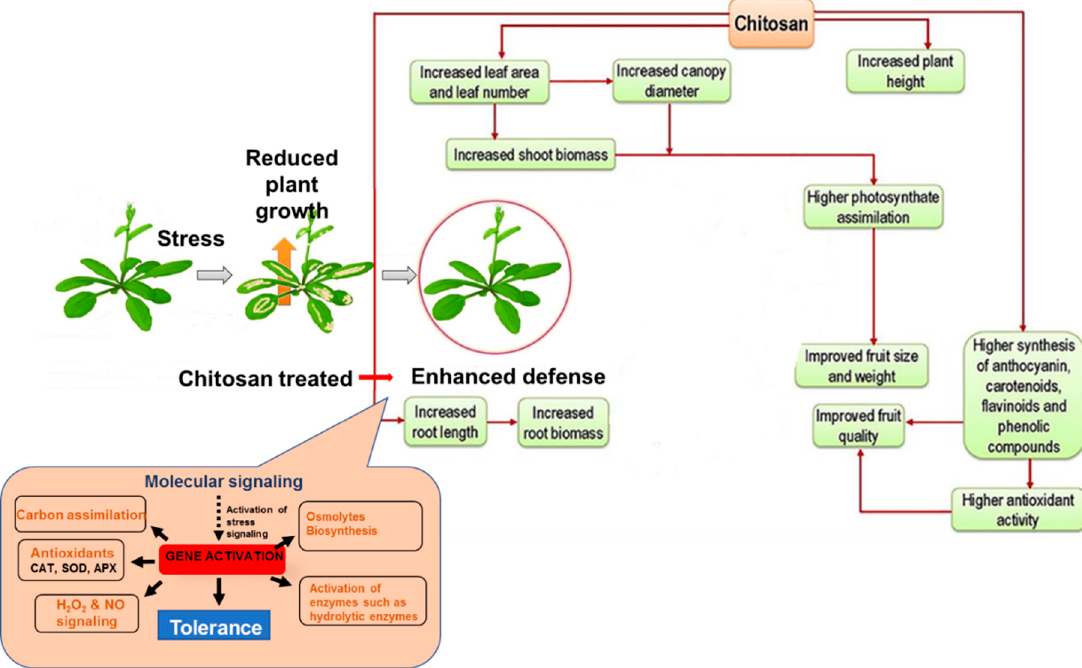
Figure 1. An overview of chitosan-mediated plant growth regulation under stress conditions.